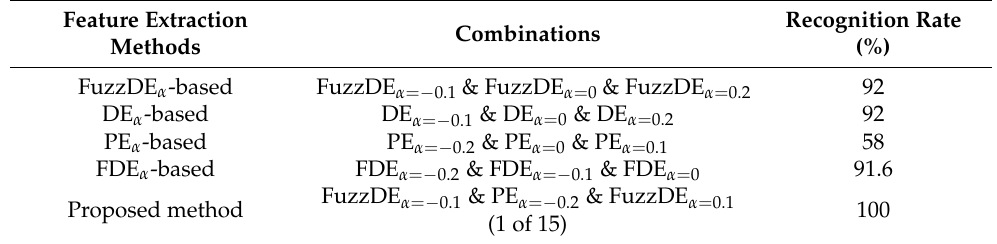
Table 4. Highest classification recognition rates for each feature extraction method (triple features).